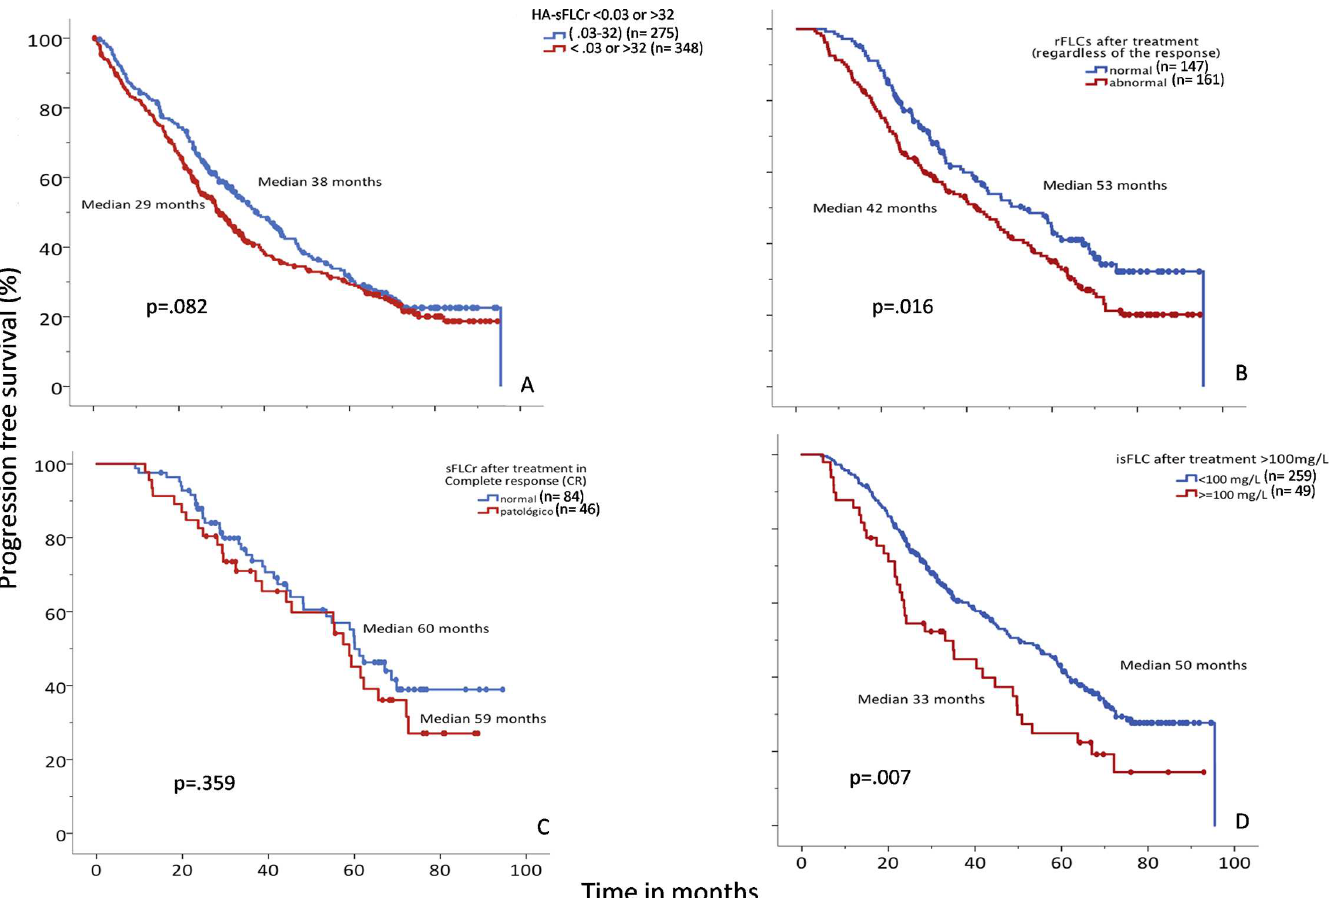
Fig 2. Progression-free survival (PFS) relationships to serum free light chain (sFLC) evaluations. (A) PFS among patients with “highly abnormal” sFLC ratios ( < 0.03 or > 32, red lines, median PFS: 38 mo) compared to those with normal sFLC ratios (0.03–32, blue lines, median PFS: 29 mo). (B) PFS among patients with normal (blue, median PFS: 53 mo) or abnormal (red, median PFS: 42 mo) sFLC ratios after treatment, regardless of the response achieved. (C) PFS among patients that achieved complete response (CR) with normal (blue, median PFS: 60 mo) or abnormal (red, median PFS: 59 mo) sFLC ratios. (D) PFS among patients with absolute involved- sFLC levels < 100 mg/L (blue, median PFS: 50 mo) or (cid:21) 100 mg/L (red, median PFS: 33 mo).